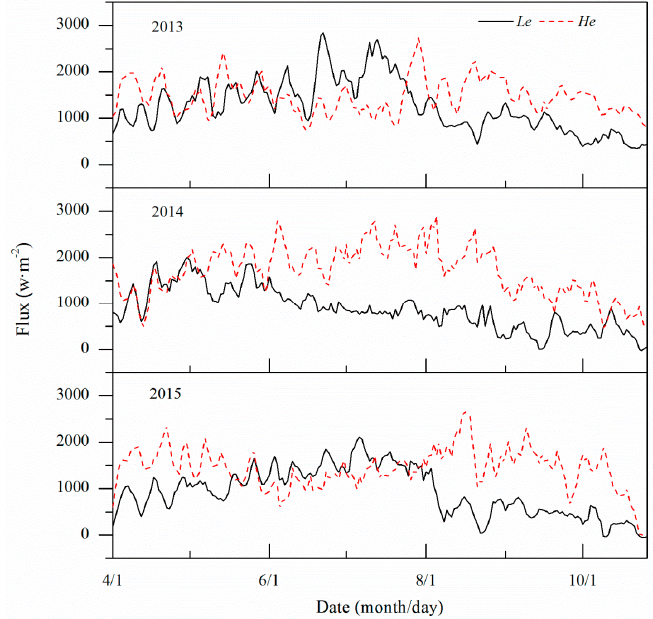
Figure 3. Comparison of the daily (5-days moving average series) latent heat flux ( Le ) and sensible heat flux ( He ) in the 2013–2015 growing seasons. Table 1. Comparison of condensation ( Q ) and precipitation ( P ) during the growing season from 2013 to 2015.